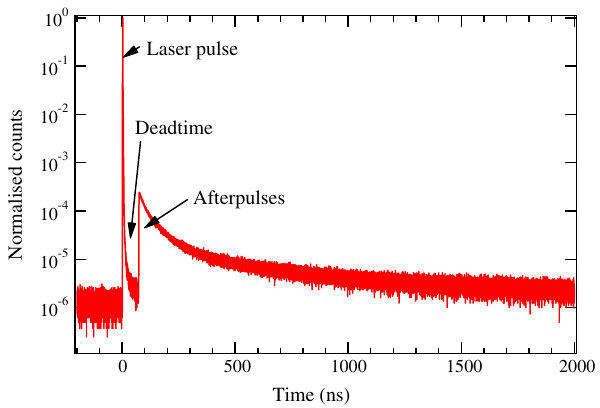
FIG. 3. Histogram of the instrument response function of the photon detection module (PDM). Measurement in the laboratory, integrated over 10 8